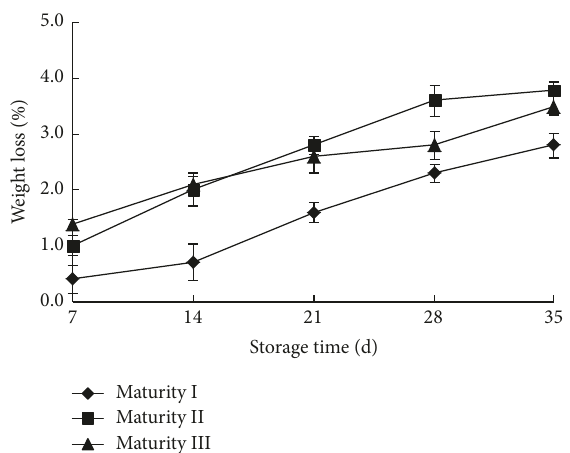
Figure9: Effectsof harvestmaturityon cell membranepermeability in apricots; fruits with maturity class I (colored area < 50%), maturity class II (colored area 50–80%), and maturity class III (colored area > 80%) were categorized according to the yellow conversion rate. Vertical bars represent the standard errors of the means of triplicate replicates.